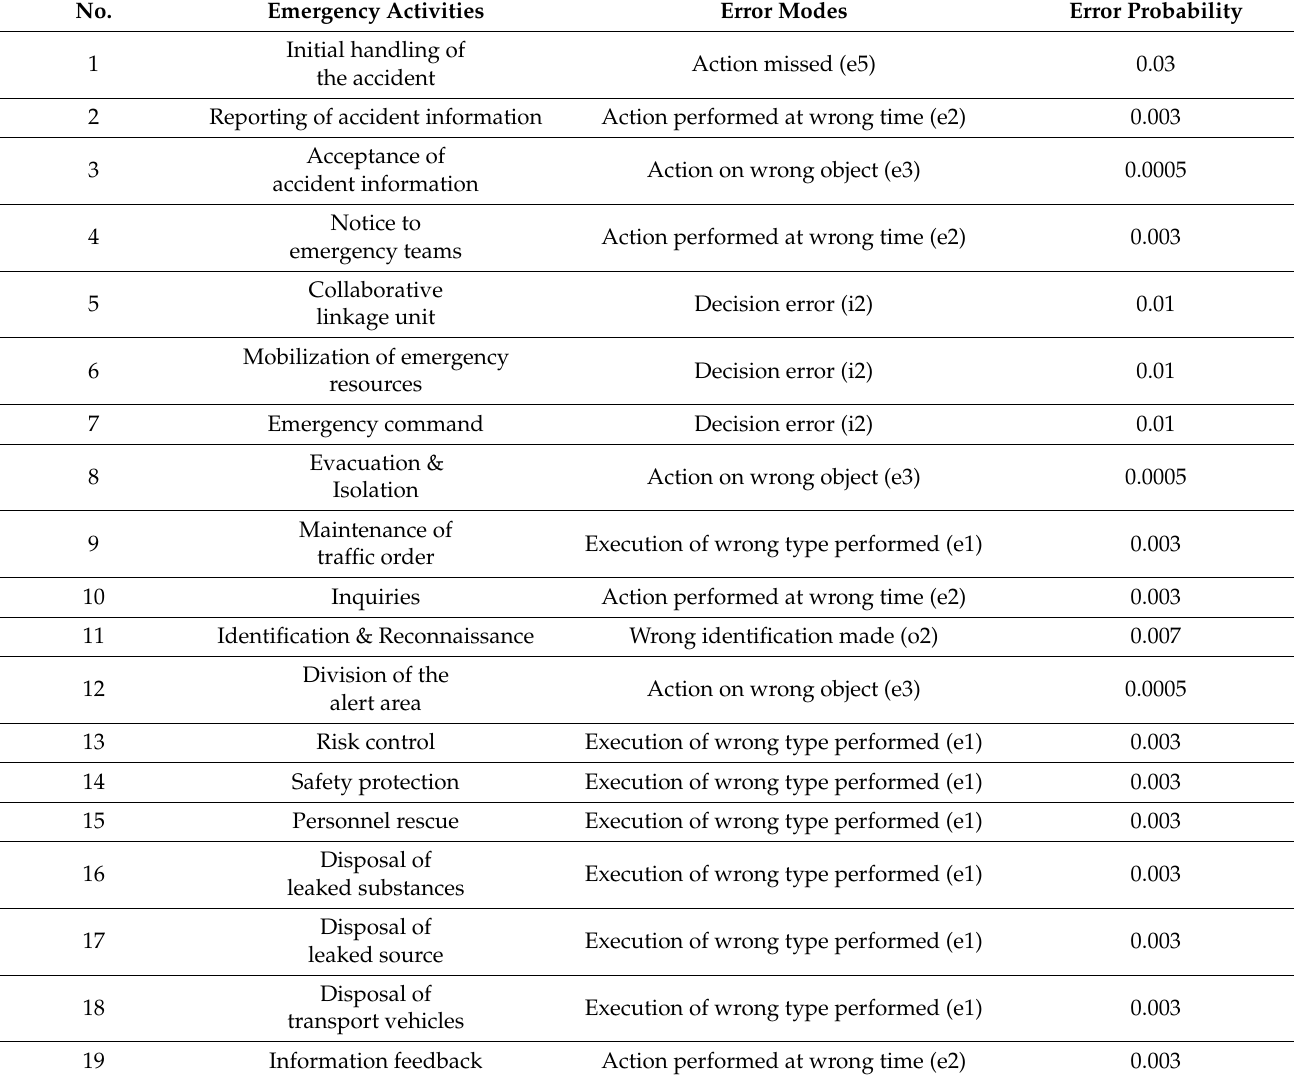
Table 5. Basic values of human error probability for emergency